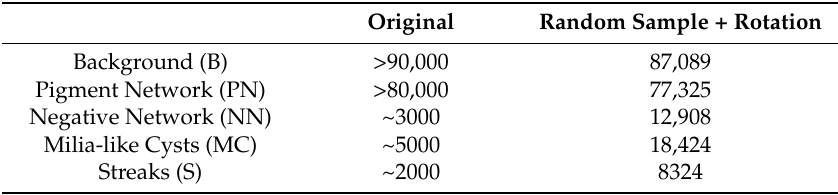
Table 2. Detailed information of data augmentation (task 2).